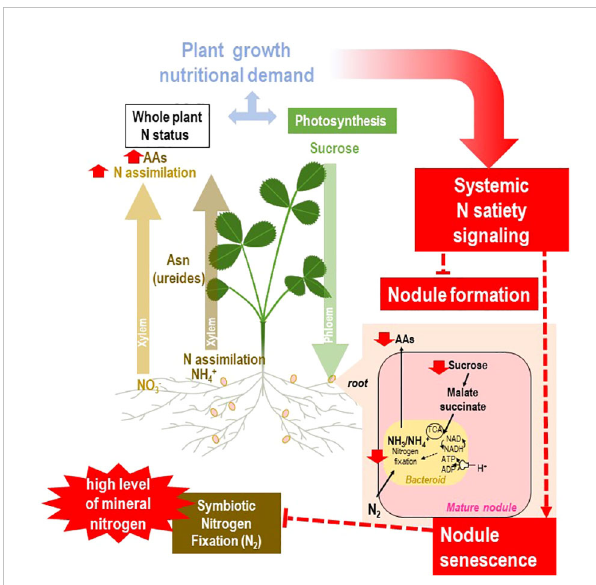
FIGURE 6 Systemic responses of the rhizobium – legume holobiont to plant N satiety. The general framework of the fi gure is described in Figure 2. Split-root systems used to characterize N-demand signaling are described in Figure 3. Various steps of the regulatory loop are indicated in red. The local availability of suf fi cient resources of mineral nitrogen ful fi lls the plant N demand. In agricultural aerated soils, NO 3 − is generally the main nitrogen source of annual crops. Assimilation of NO 3 − occurs mainly in shoots. Satisfaction of the whole N demand results in repressive systemic signaling, arresting nodule formation. In mature nodules, the N-satiety systemic signaling results in drastic reduction of nodule sucrose levels and rapid activation of nodule senescence and bacteroid proteolysis, associated with a sharp decrease in nitrogen fi